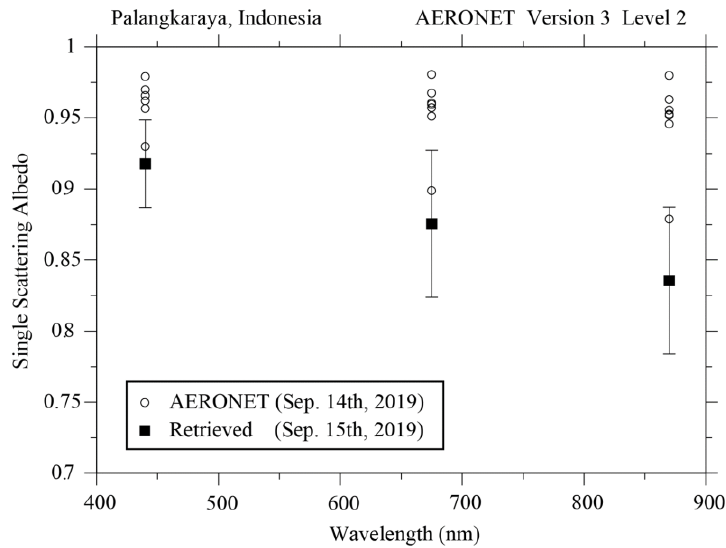
Figure 10. Single scattering albedo (SSA) at 443 nm, 674 nm, and 869 nm. The open circles represent AERONET measurements obtained on 14 September 2019. The filled black squares were retrieved from the second-generation global imager (SGLI) on 15 September 2019.